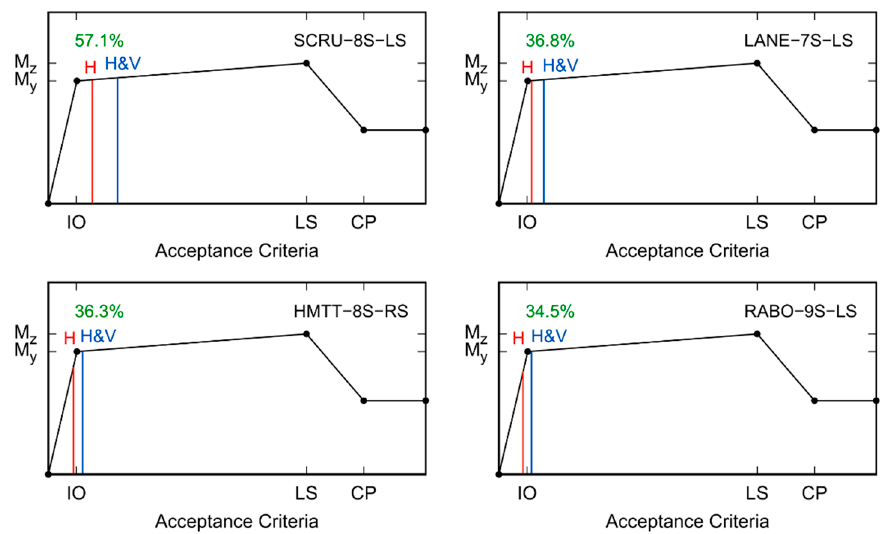
Figure 18. Examples of acceptance criteria for the 10-story building. Part 2.